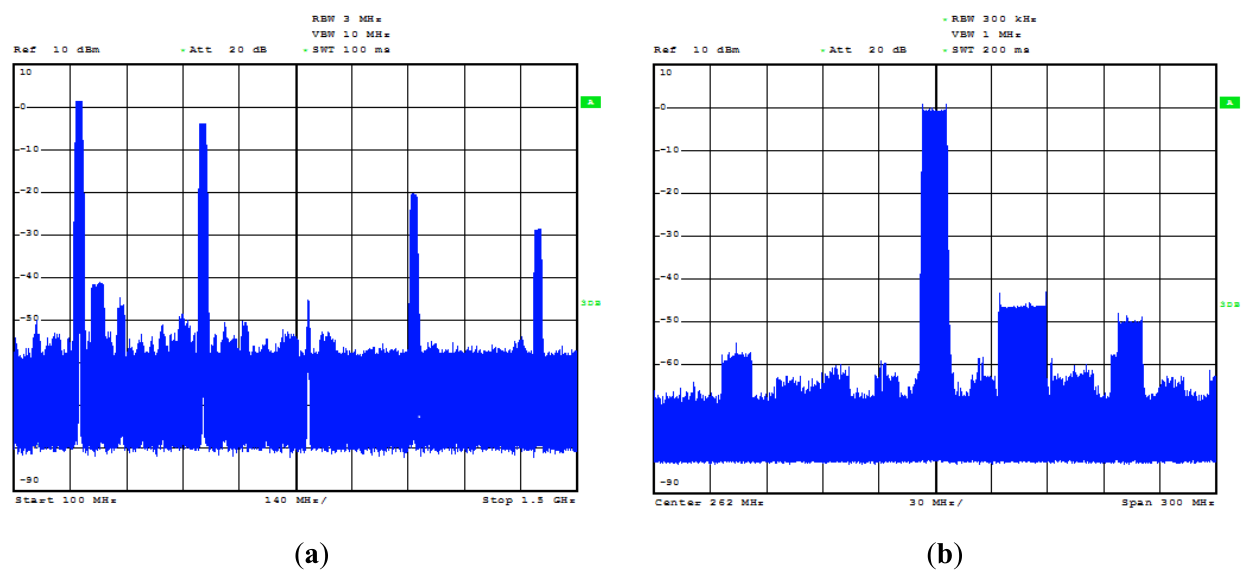
Figure 4. Frequency spectrum of the 262 MHz centered, 12 MHz bandwidth triangular SLFM-CW signal generated by the DDS (before filtering and up-conversion